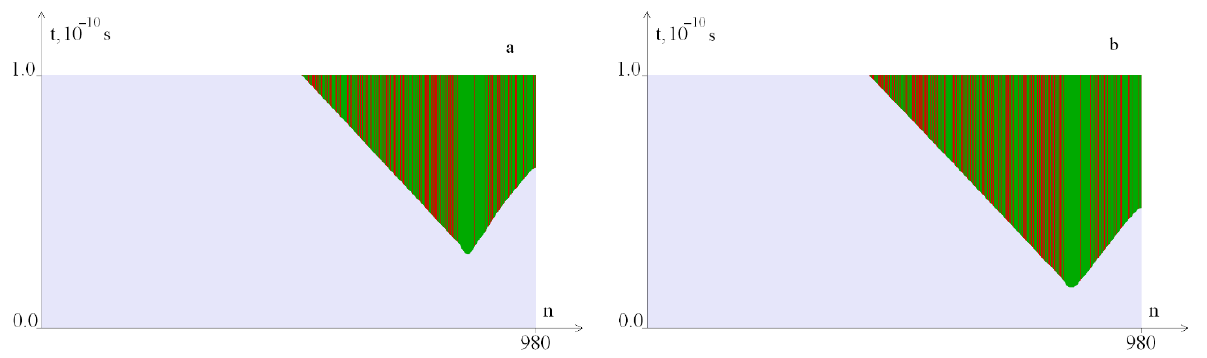
Figure 11. OS regions arising under the localized torque action on the segment [781, 880] (a — at M 0 = 15.046, b — at M 0 = 16). Green indicates OS in A – T pairs, red, in G – C pairs.